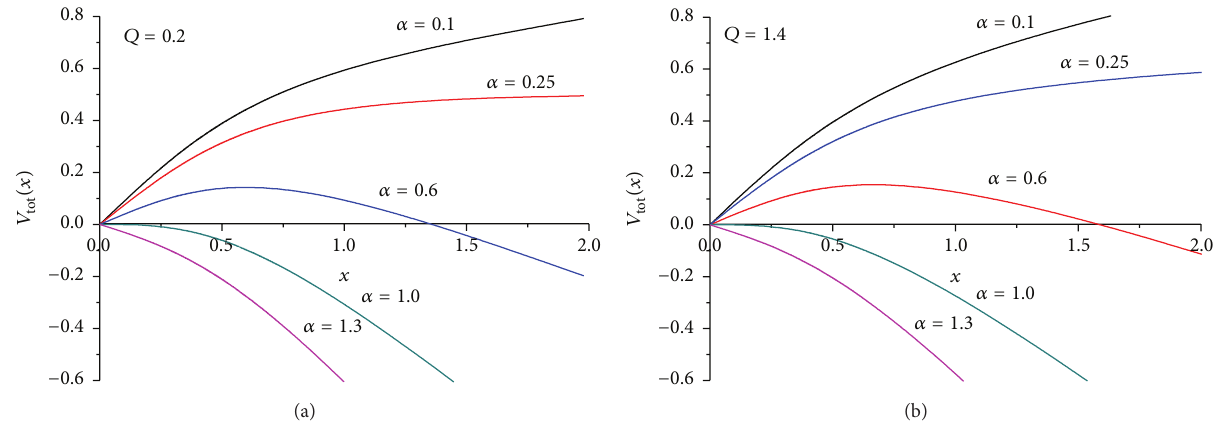
Figure 1: The total potential versus distance 𝑥 with two different values of 𝑄 . (a) 𝑄 = 0.2 ; (b) 𝑄 = 1.4 . In all of the plots from top to bottom 𝛼 = 0.1, 0.25, 0.6, 1.0, 1.3